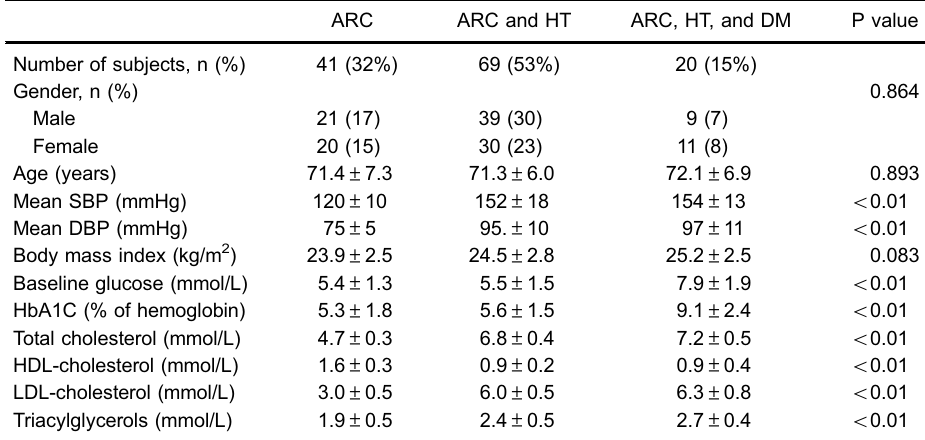
Table 1. Basic demographical, clinical, and biochemical characteristics of patients.